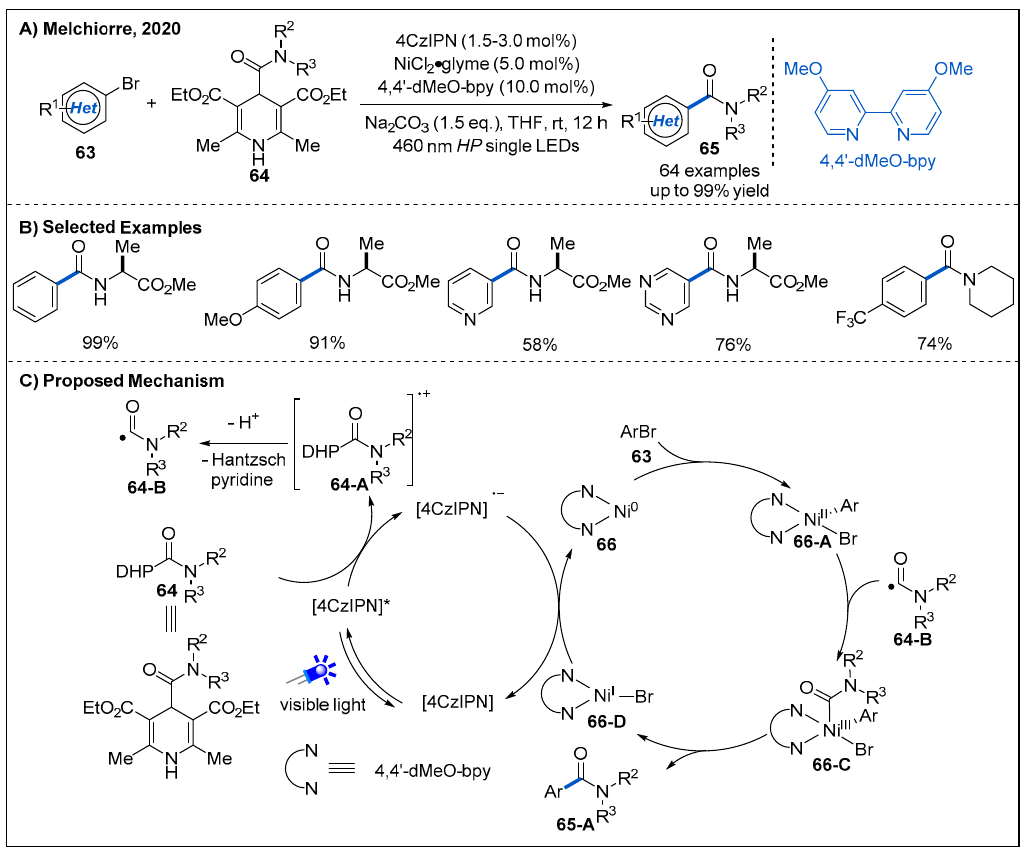
Figure 21. Amide synthesis by nickel/photoredox-catalyzed direct carbamoylation of (hetero)aryl bromides.